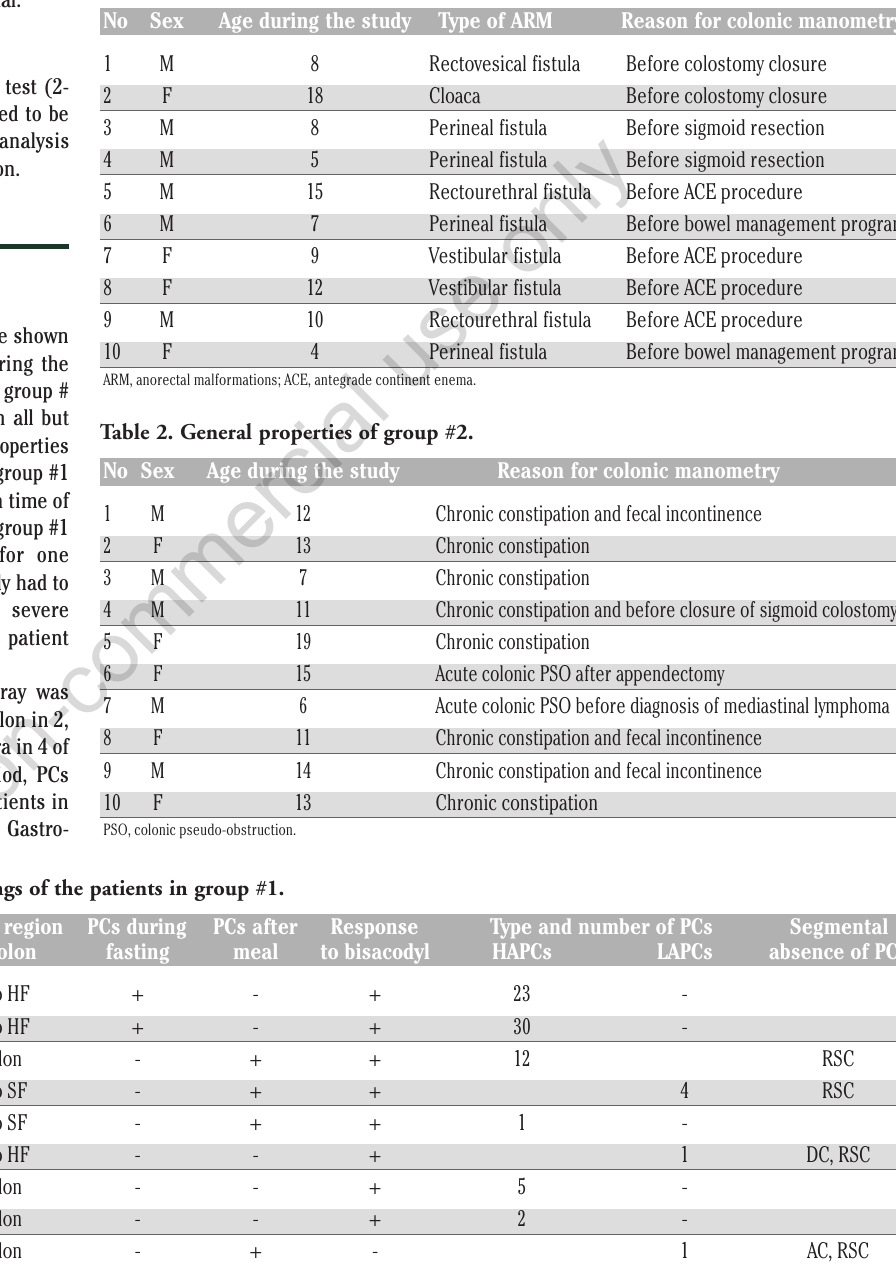
Table 1. General properties of group # 1.